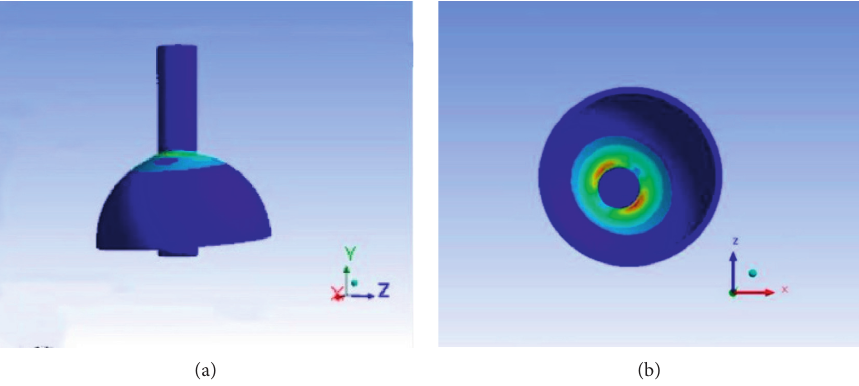
Figure 9: The plane view and bottom view of hemispherical resonator’s